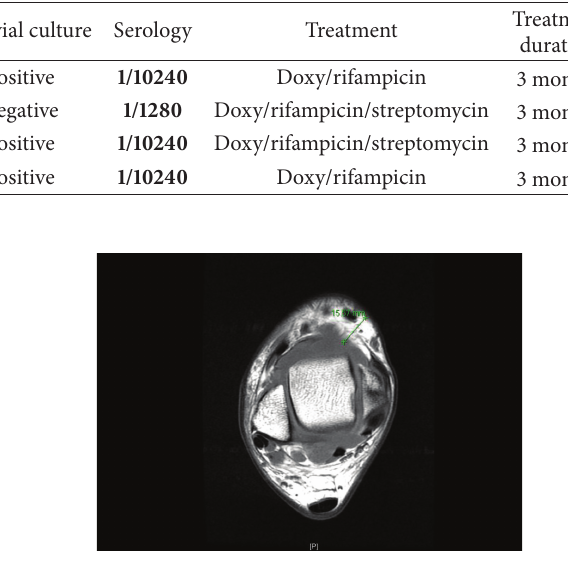
Figure 1: Moderate (L) knee joint effusion with OA.